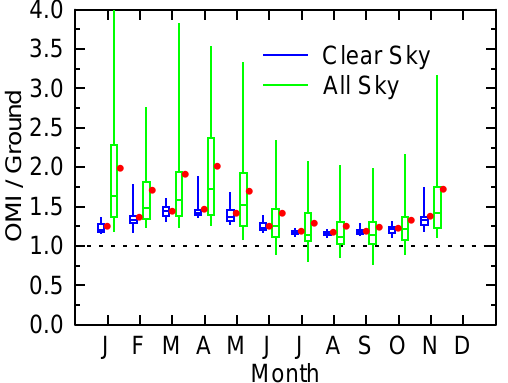
Figure 13. Ratio of overpass erythemal dose rate (DP 1) measured by OMI and the radiometer at Trondheim. Box-whiskers represent the distribution of ratios filtered for clear-sky (blue, left of month marker) and all-sky (green, right of month marker), and indicate the 5th and 95th percentile (whisker), the interquartile range (box), median (line), and average (red dot). Match-up data were filtered for SZA < 84 ◦ and Dis <